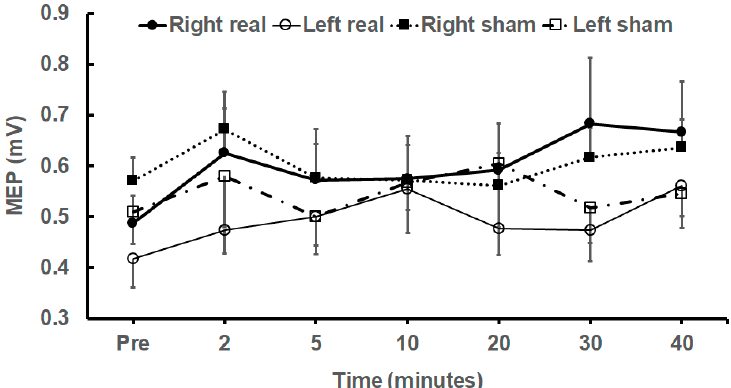
Figure 2. Mean MEP (±SEM) amplitudes (mV) recorded from the right (filled symbols) and left (open symbols) Tibialis Anterior muscles before and after 20 minutes anodal (circles) and 20 minutes of sham (squares) tDCS.